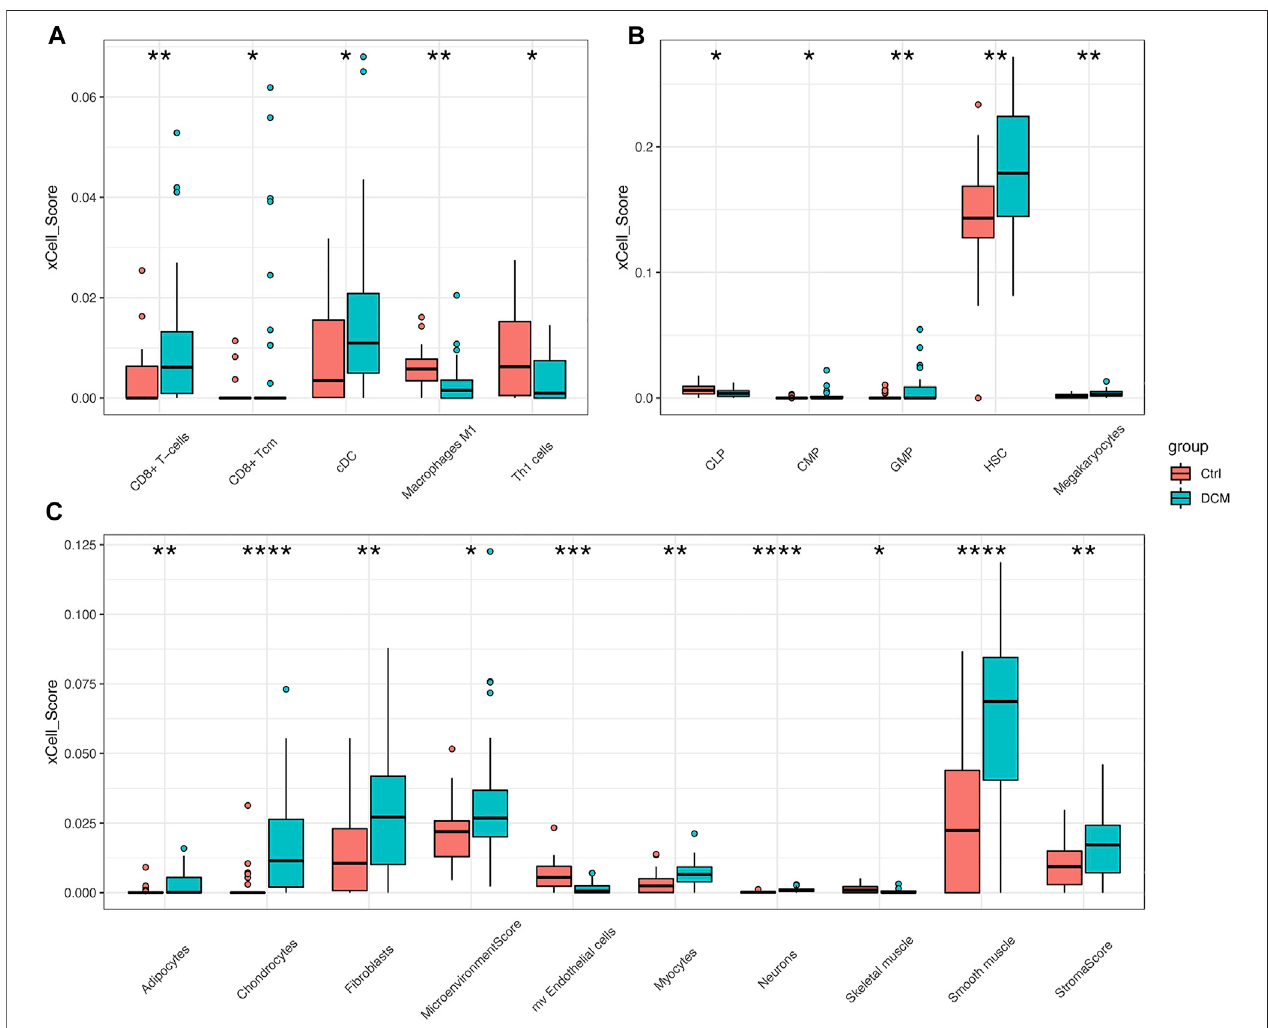
FIGURE 4 | xCell scores of immune and stromal cells between DCM and control heart tissues in merged dataset (A – C) Boxplots of “ lymphoid and myeloid cells ” , “ stem cells ” , “ stromal cells and others ” respectively. * p < 0.05, ** p < 0.01, *** p < 0.001, **** p < 0.0001.